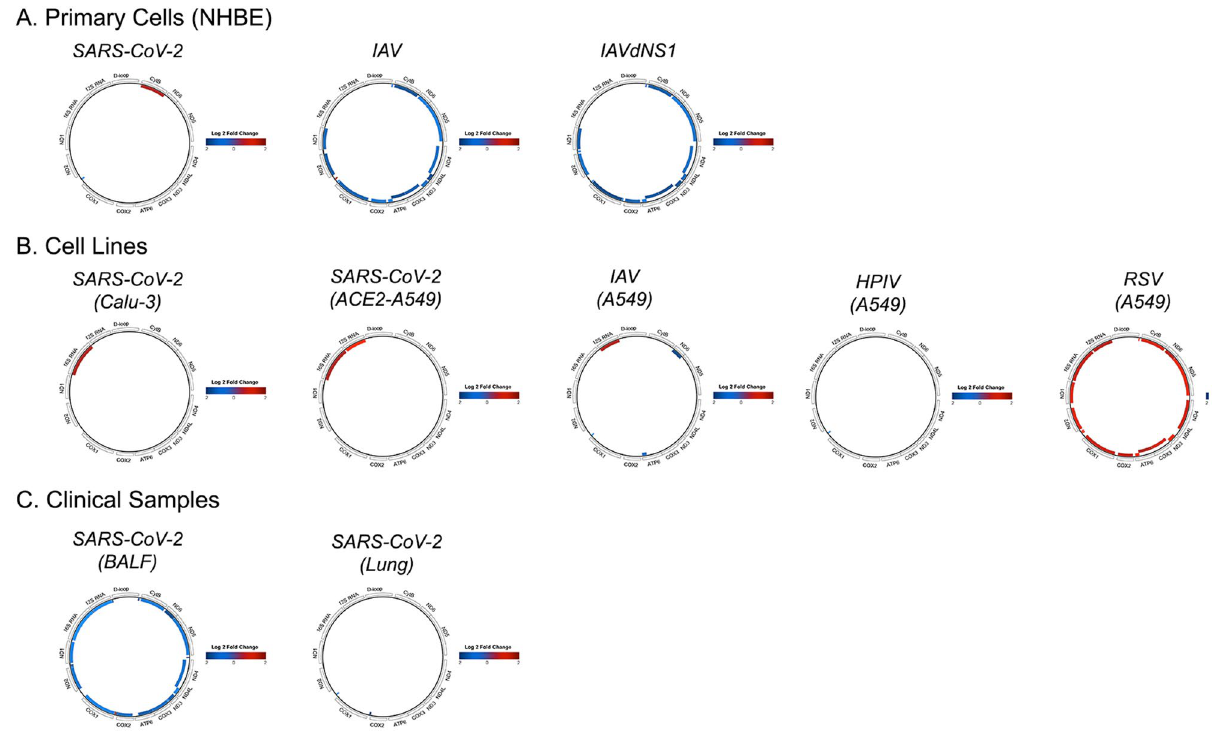
Figure 1. Mitochondrial-gene expression after viral infection in primary cells ( A ), cell lines ( B ), and clinical samples ( C ). Colored genes indicate log twofold change with a padj <